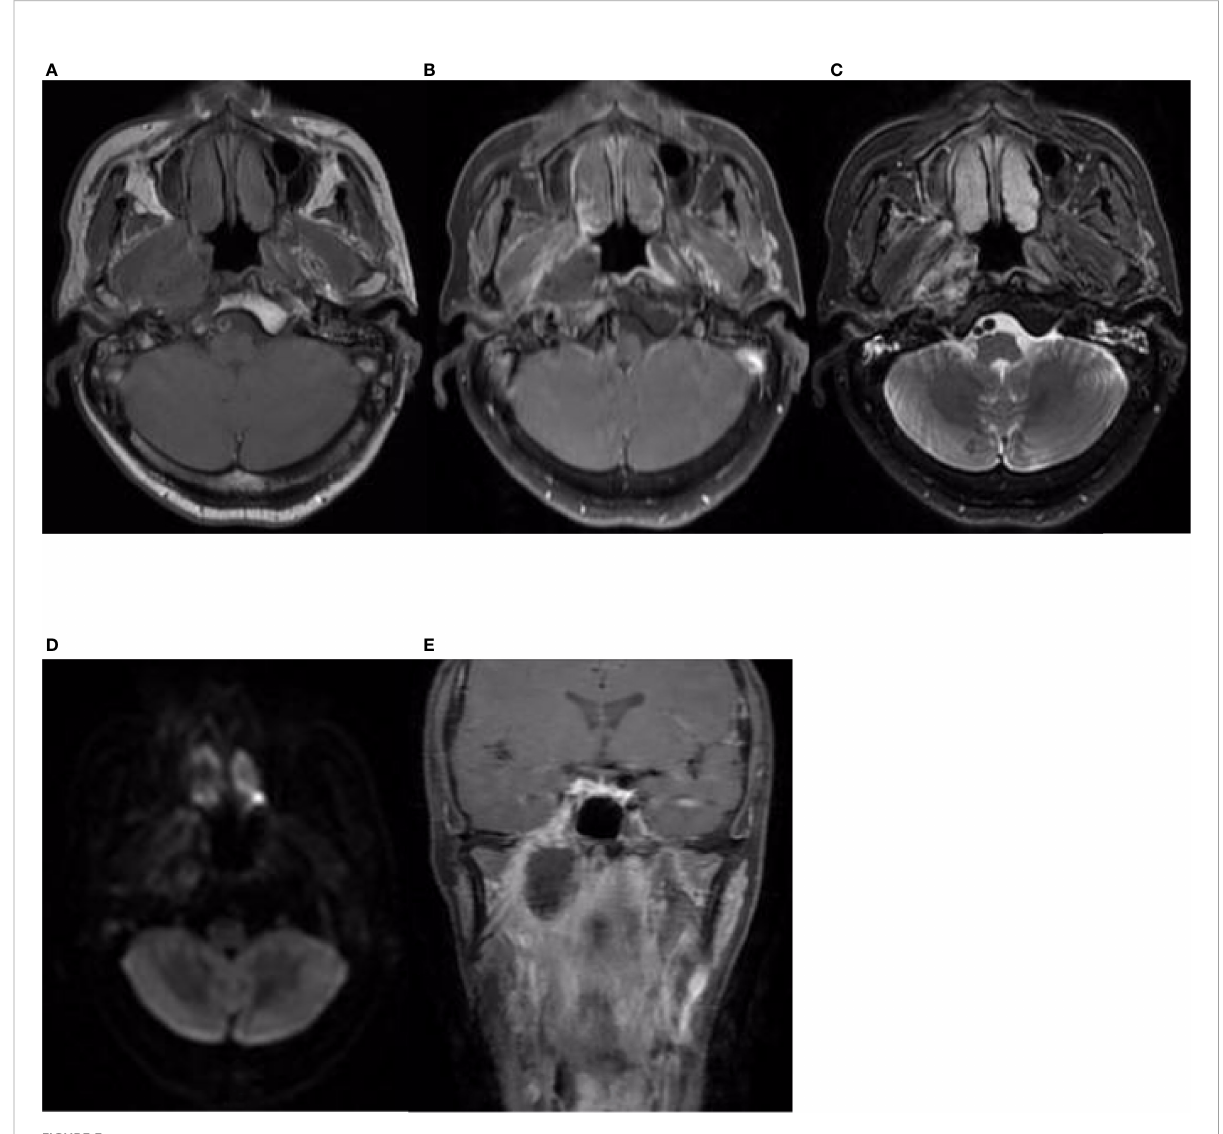
FIGURE 3 Nasopharynx and neck MRI fi ndings from 29 July 2019. (A – D) The axial planes of T1-weighted, enhanced T1-weighted, T2-weighted, and DWI and (E) the coronal plane of enhanced T1-weighted MRI, showing that the nasopharyngeal lesions on the right side subsided signi fi cantly, but there was a 4.8 cm × 3.0 cm × 2.7 cm residual area of low signal and no enhancement, which suggested